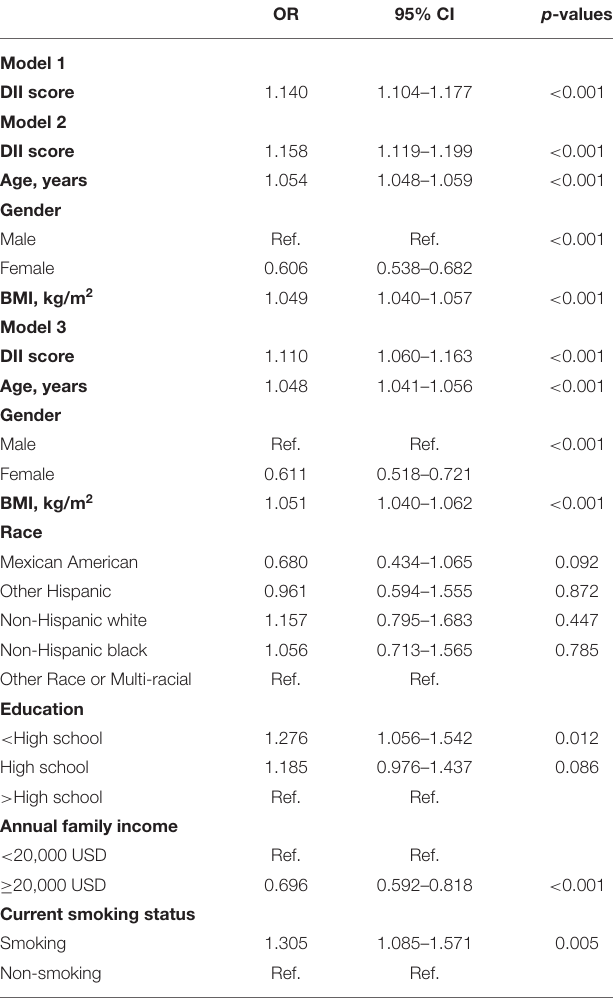
TABLE 3 | Logistic regression analysis of DII on HF in participants with cardiac-cerebral vascular disease in NHANES (1999–2018). OR